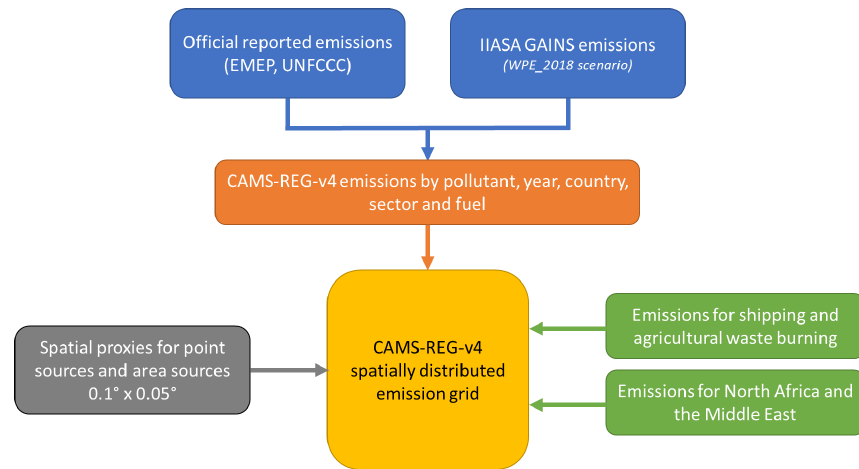
Figure 1. General methodology applied for the CAMS-REG emission